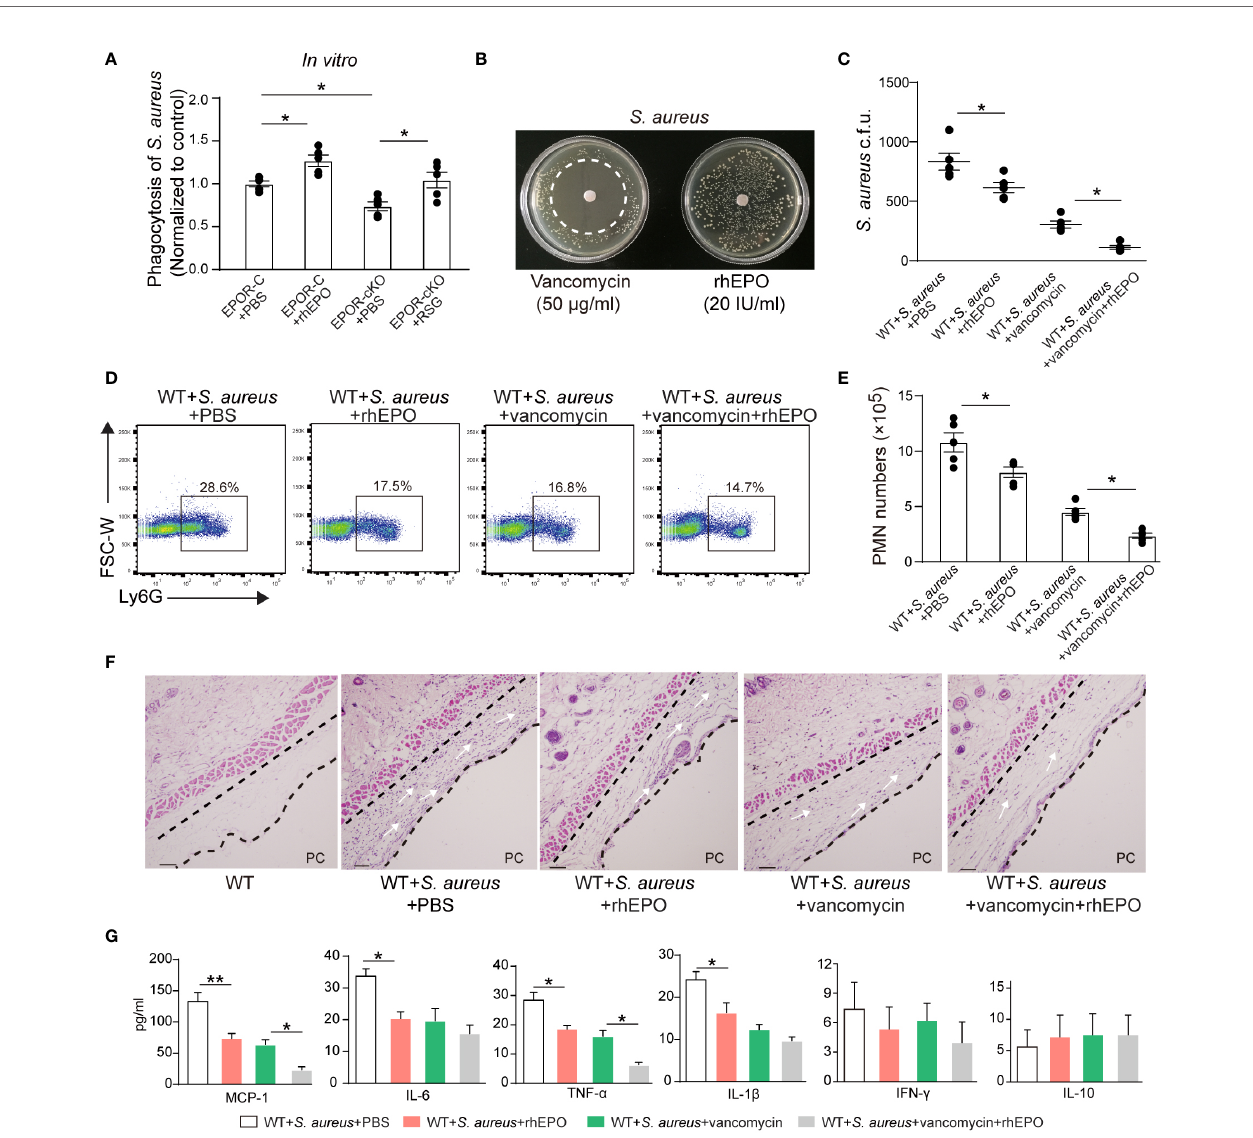
FIGURE 7 | EPO promotes bacterial phagocytosis and enhances actions of vancomycin in S. aureus -initiated infections. (A) : Thioglycolate-elicited peritoneal macrophages from EPOR-C or EPOR-cKO mice were pretreated with rhEPO (20 IU/ml, 24 hrs), RSG (10 m M, 48 hrs) or PBS for 24 hrs and then incubated with fl uorescently labeled S. aureus for 30 min (macrophage: S. aureus = 1: 10). In vitro phagocytosis of S. aureus by macrophages was analyzed by fl ow cytometry (n = 5). (B) : Vancomycin (50 m g/ml, as a positive control) or rhEPO (20 IU/ml) were each placed on BHI agar plates containing S. aureus (10 6 c.f.u.). The zone of clearance was assessed after overnight incubation. Representative plates from each group are shown in photographs. (C – G) : WT mice dorsal pouches were given live S. aureus (2 × 10 5 c.f.u.) together with rhEPO (5,000 IU/kg), vancomycin (50 mg/kg), both rhEPO (5,000 IU/kg) and vancomycin (50 mg/kg) or PBS by intra- pouch injection. Thereafter, pouch exudates were collected for the measurement. (C) : Bacterial counts of S. aureus (c.f.u.); (D) : Representative fl ow cytometric dot plots of neutrophils in pouch exudates; (E) : Exudate PMN numbers; (F) : skin HE staining (PC, pouch cavity. Bars, 50 m M) at 24 h (n = 5); (G) : In fl ammatory cytokines in pouch exudates (n = 3). Data are representative of at least two independent experiments. Results were expressed as mean ± SEM. * P < 0.05, ** P < 0.01. Statistics: one-way ANOVA with Tukey ’ s post hoc test for multiple comparisons (B, C, E, G)